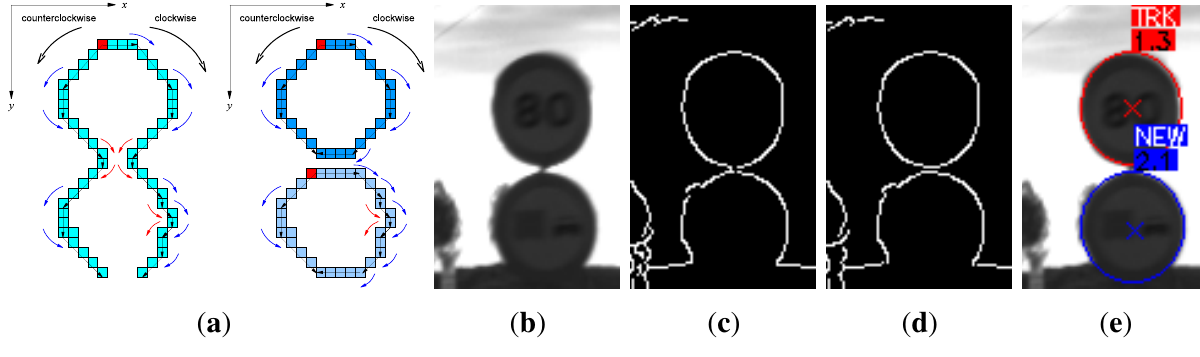
Figure 2. Encoding step, ( a ) graphical application of the algorithm; ( b ) Real sign; ( c ) Canny image; ( d ) split and merge; ( e ) Detection